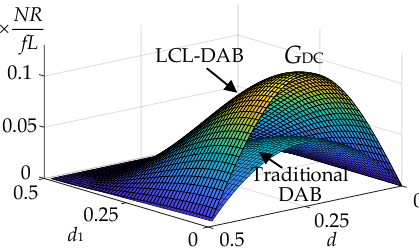
Figure 7. Output voltage gain comparison for the two types of converters.